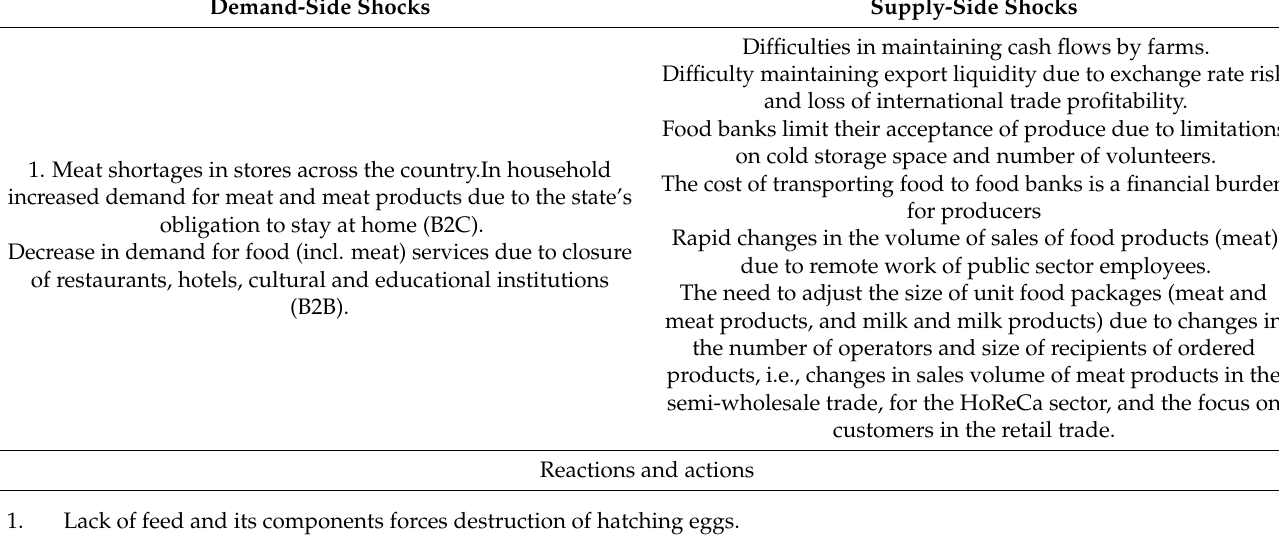
Table 6. The case of Russia on the poultry meat